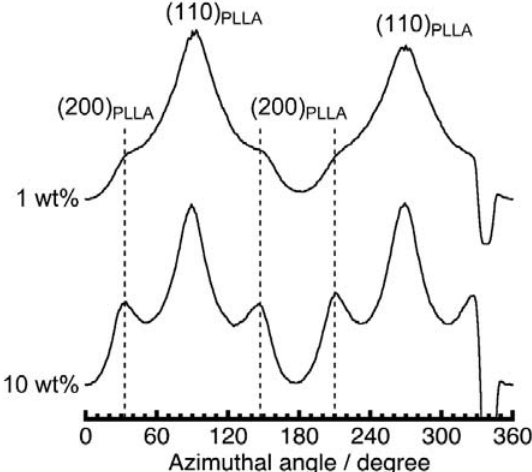
Figure 12. Comparison of the azimuthal plots scanned at 2 θ ≈ 16.7° in the 2D-WAXD images of PPAZn/PLLA-8TR with both concentrations of PPAZn (1 and 10 wt %). The (200) diffraction peaks of PPAZn/PLLA-8TR containing 10 wt % PPAZn were more clearly detected than those containing 1 wt % PPAZn.